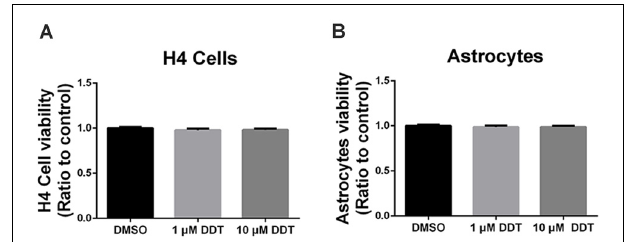
FIGURE 1 | Dichlorodiphenyltrichloroethane (DDT)-related cytotoxicity in H4 human neuroglioma cells and immortalized astrocytes. (A) Viability of H4 human neuroglioma cells. (B) Viability of immortalized astrocytes. Mean ± SEM, n = 3.